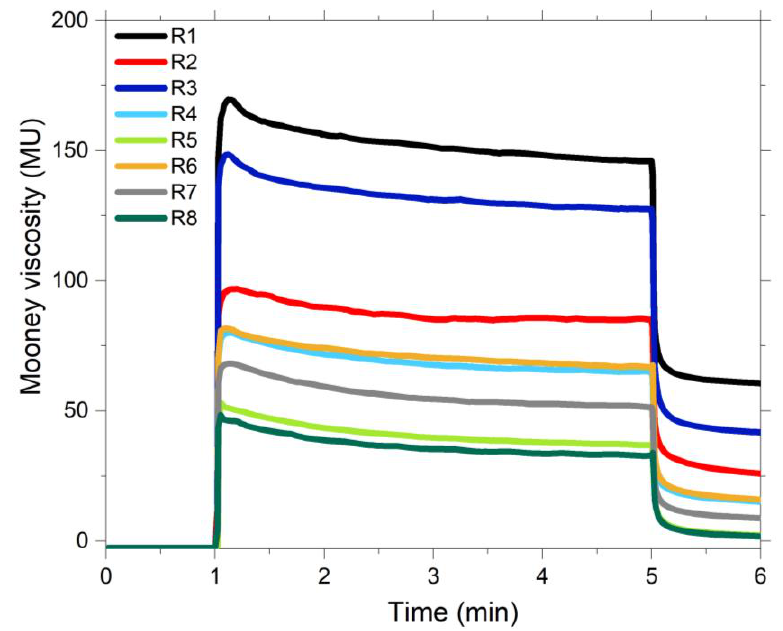
Figure 3. Mooney viscosity of the studied